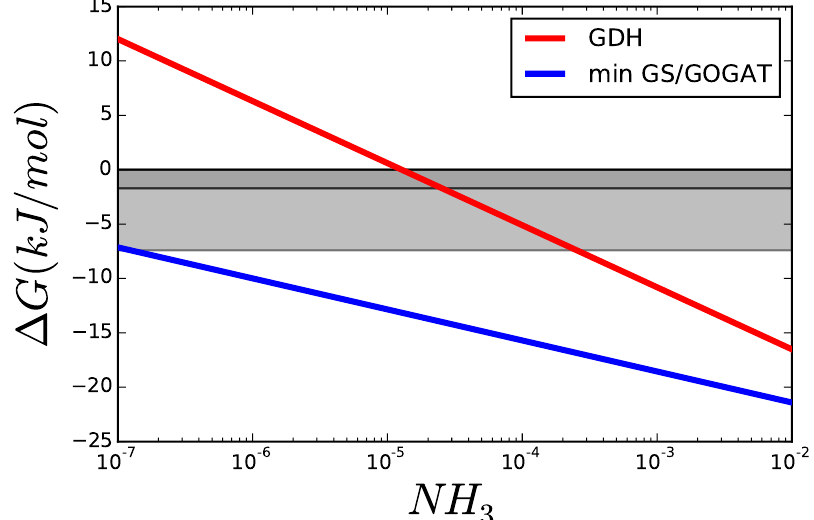
Figure 9. Comparison of ∆ G of GDH and GS/GOGAT applying the Max-min Driving Force principle so that both GS and GOGAT have the same ∆ G . The greyed areas mark values, where ∆ G is similar enough to R T that the thermodynamic factor 1 − θ decreases rapidly. The darker area marks ∆ G , and the lighter ∆ G 50% 95%